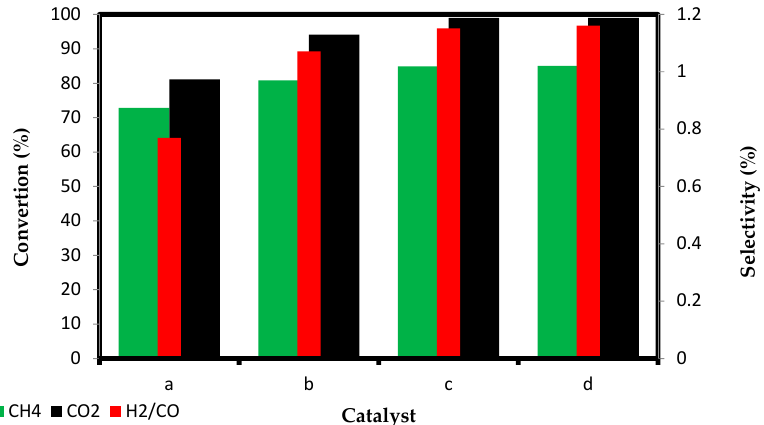
Table 4. The catalytic results of DRM reaction for the catalysts at 900 °C for the 1:1 ratio of CH 4 :CO 2.